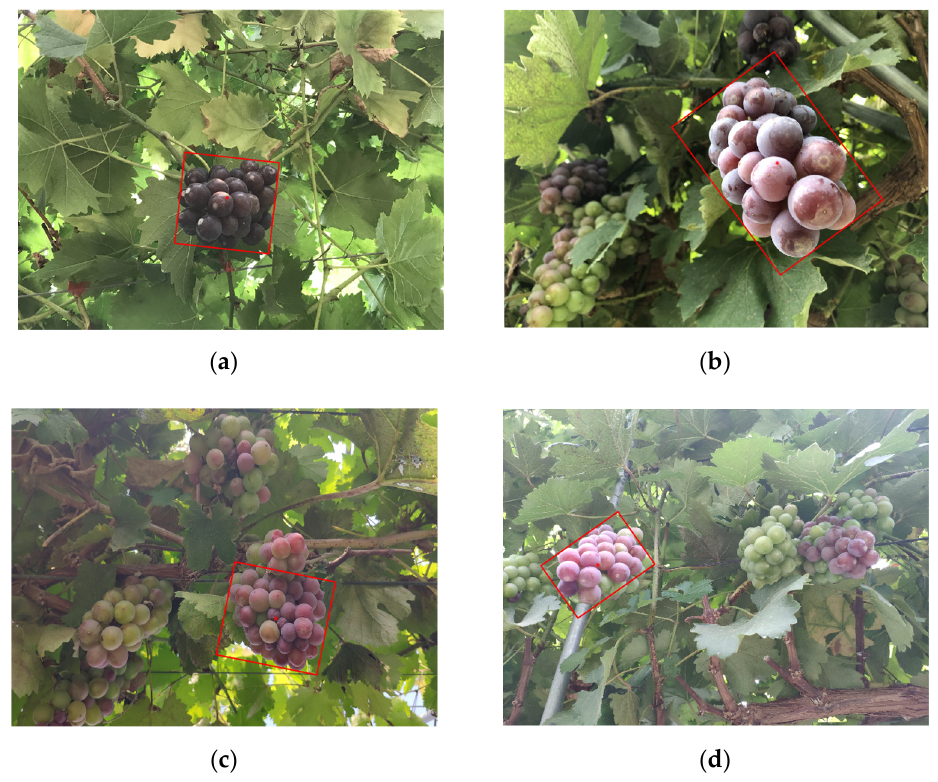
Figure 5. Image of partial test result. ( a ) Test 1. ( b ) Test 2. ( c ) Test 3. ( d ) Test 4.